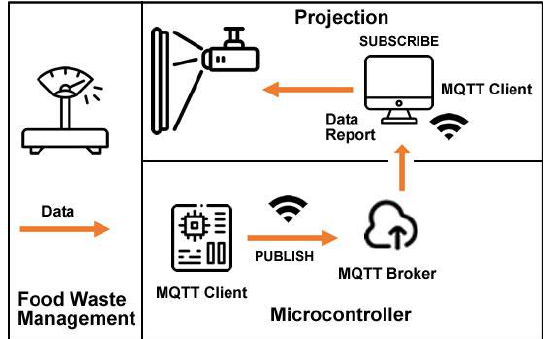
Figure 9. SmartWaste System Architecture.